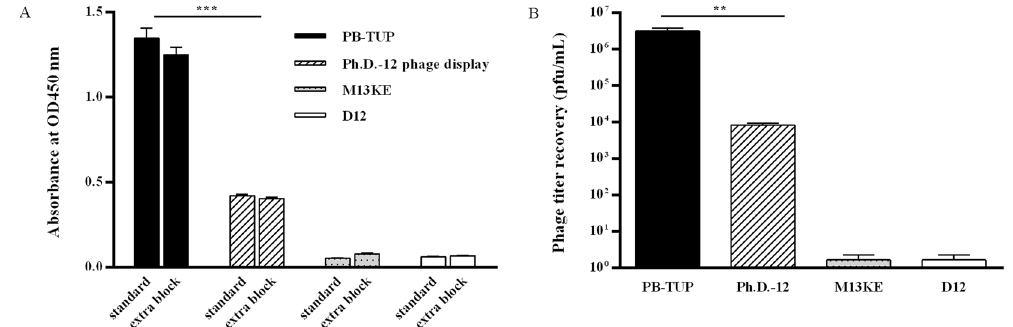
Figure 3. Evaluation of secondary antibody binding to polystyrene. ( A ) The standard protocol lack of extra NFM-TBS blocking versus extra blocking before adding HRP-conjugated anti-M13 antibody in ELISA. No significant differences were found between these two ELISA conditions of PB-TUP binding. Significant differences in binding ability were observed between PB-TUP clone and other clones. ( B ) 10 10 Phage clones were added to the microtiter plates separately. Polystyrene binding phages were recovered by acid elution and titrated. There were significant differences between the phage titer of recovered PB-TUP clone and other phage